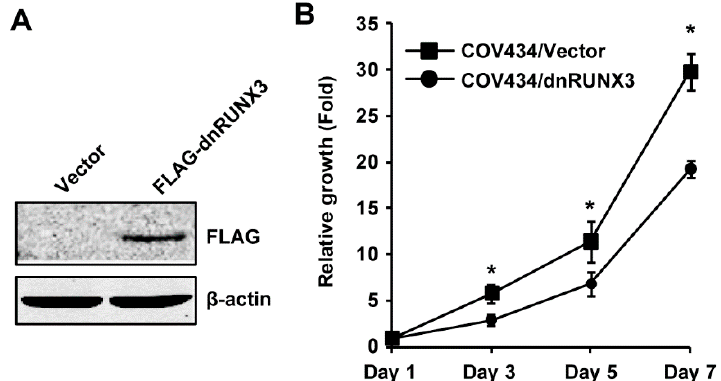
Figure 4. Inhibition of RUNX3 by a dominant–negative form of RUNX3 decreases growth of COV434 cells. ( A ) Expression of RUNX3 (1–187), a truncated RUNX3 that functions as a dominant–negative RUNX3 (dnRUNX3), was confirmed by immunoblotting using a FLAG antibody. β -actin was used as the loading control. ( B ) DnRUNX3 decreased cell growth of COV434 cells as determined by the neutral red uptake assay. The relative cell growth in each cell type was normalized to their respective day 1 controls. Data are shown as mean ± SE of three independent experiments. * Significantly different ( p < 0.05).